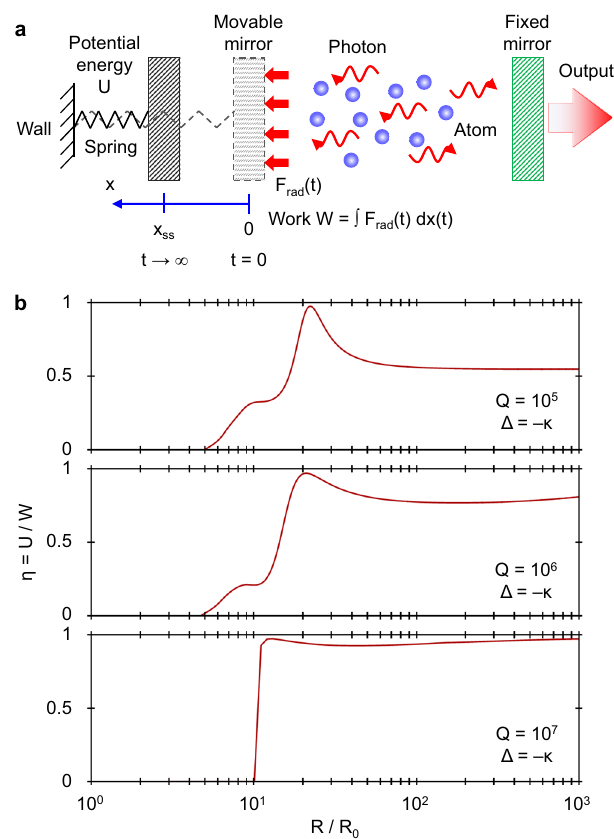
Fig. 3 Ef fi ciency of the optomechanical coupling. a Energy transfer from the laser light to the spring – mass oscillator. Initially, the positions of two mirrors of the optical cavity are fi xed and the intracavity fi eld reaches the steady state. Then, the moveable mirror is free to move. The radiation pressure F ð t Þ pushes the movable mirror away from the initial position rad x ð t ¼ 0 Þ ¼ 0. As the time goes in fi nity, t ! 1 , the position of the movable mirror approaches the steady-state displacement x ð t ¼ 1Þ ¼ x . During R ss t ¼1 this process, the radiation pressure does the work W ¼ F rad ð t Þ dx ð t Þ . t ¼ 0 When the moveable mirror is displaced at x , the potential energy stored in ss the spring – mass oscillator is U . The energy conversion ef fi ciency from W to U is given by η ¼ U = W . b Ef fi ciency η vs. the pump rate R for different cavity Q factors. Here, R 0 is the minimum pump threshold. The atom – cavity detuning is set at Δ ¼ (cid:2) κ with the cavity loss rate κ